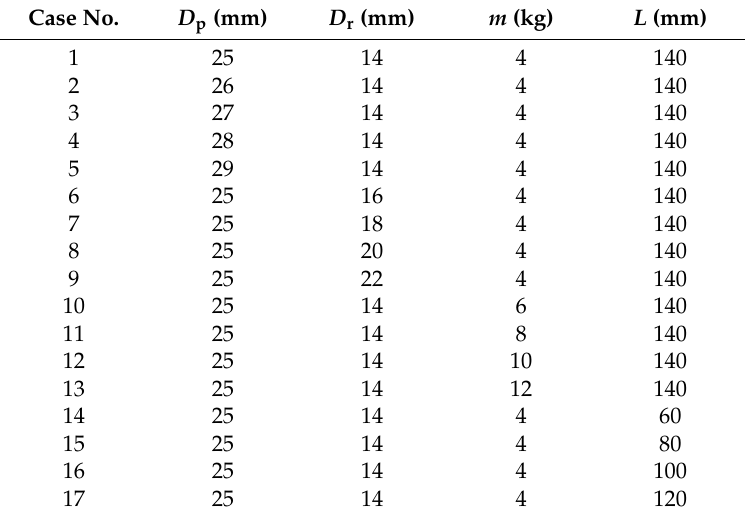
Table 2. The values of parameters of the impact body investigated in the current study. Case